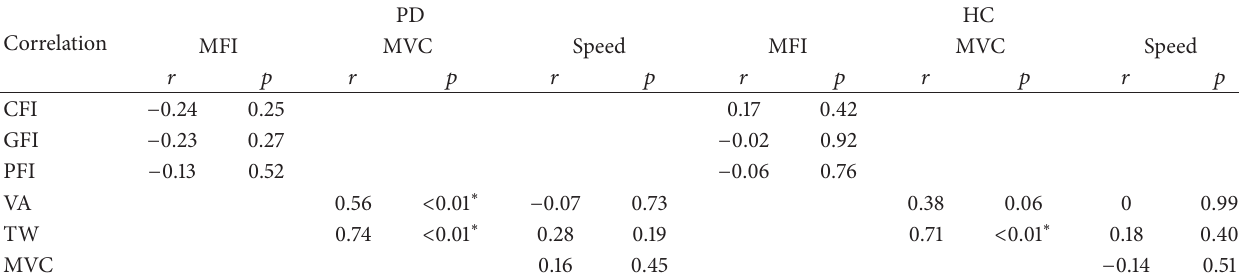
Table 2: Correlation analysis between variables in the two